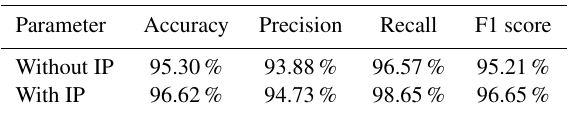
Table 2. Comparison of indicators before and after using IP tech- nology. Parameter Accuracy Precision Recall F1 score Without IP 95.30% 93.88% 96.57% 95.21% With IP 96.62% 94.73% 98.65%